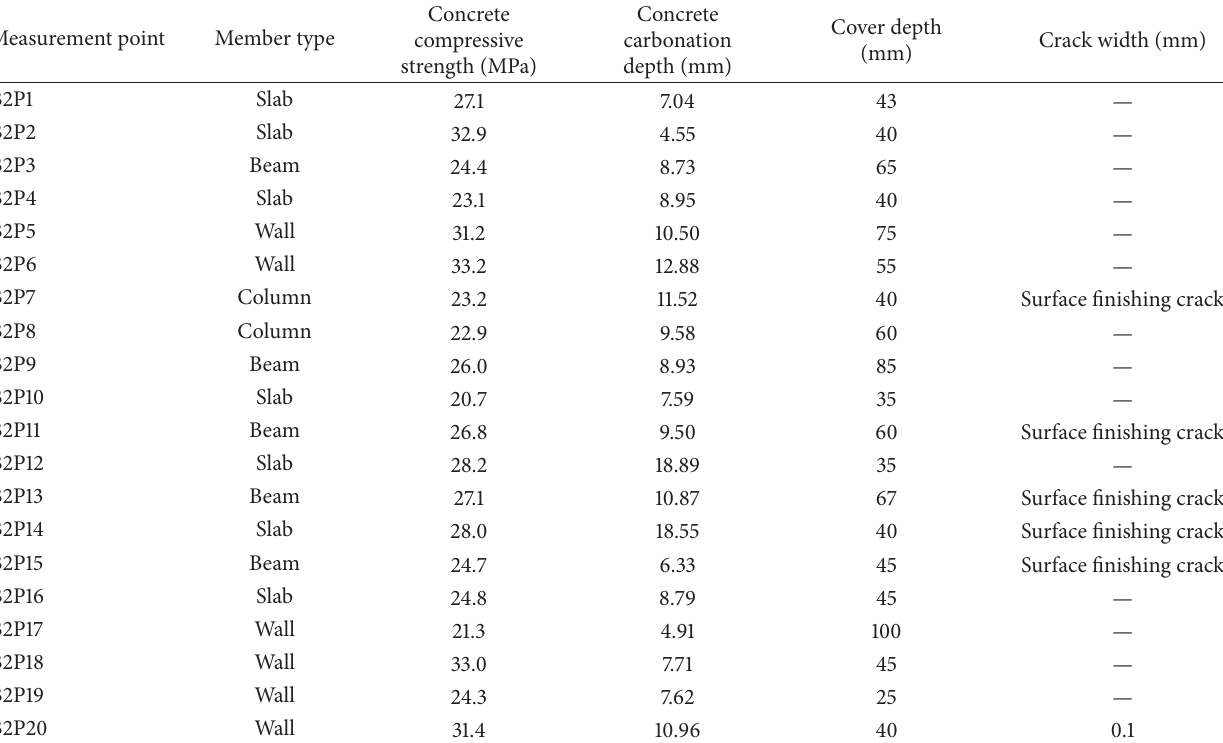
Table 4: Field investigation data (Building 2, construction completion year: